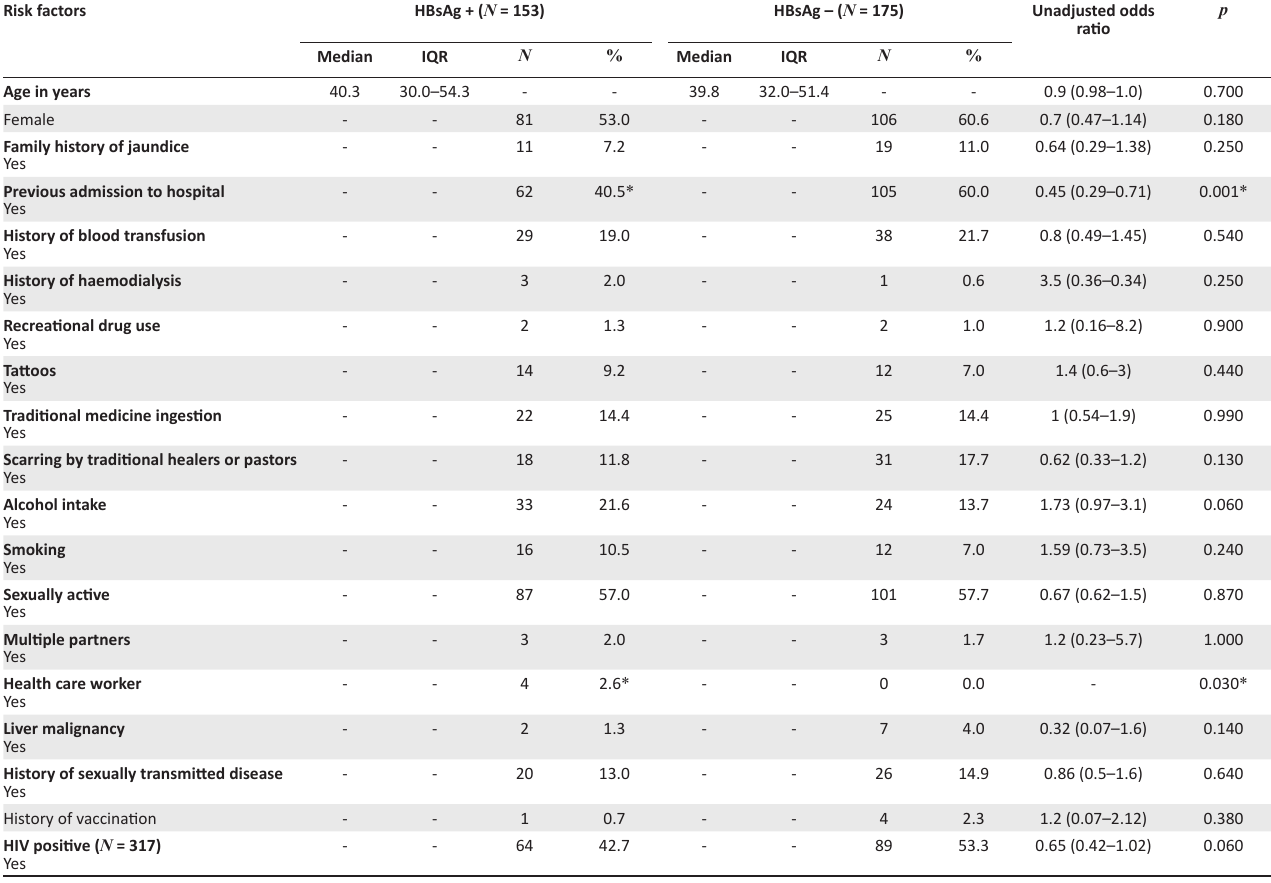
TABLE 1: Risk factors in patients with positive hepatitis B surface antigen. Risk factors